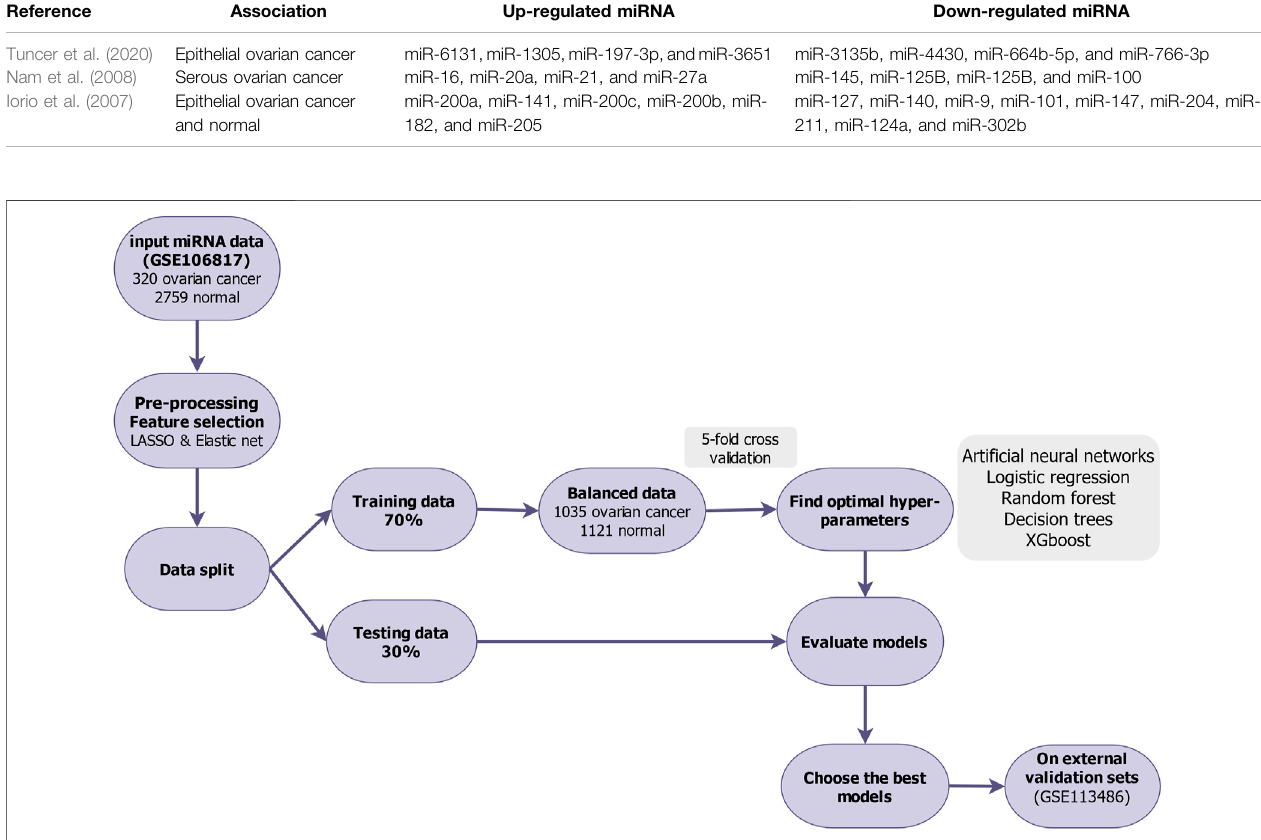
FIGURE 1 | Flowchart of feature selection and model building in the study.